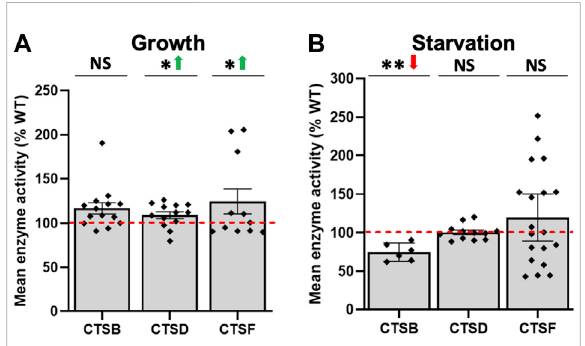
FIGURE 9 Loss of cln5 affects the activity of cathepsins during growth and starvation. The activity of cathepsins were assessed during (A) growthand (B) 4-hourstarvationinWTand cln5 - cellsasdescribed in the Materials and methods. Activities in whole cell (WC) lysates were subtracted from the blank solution and activities in cln5 - lysates were standardized against the activities in WT samples. Data presented as mean enzyme activity (% WT) ± SEM (n ≥ 6). * p < 0.05, ** p < 0.01 (one sample t -test). NS – not signi fi